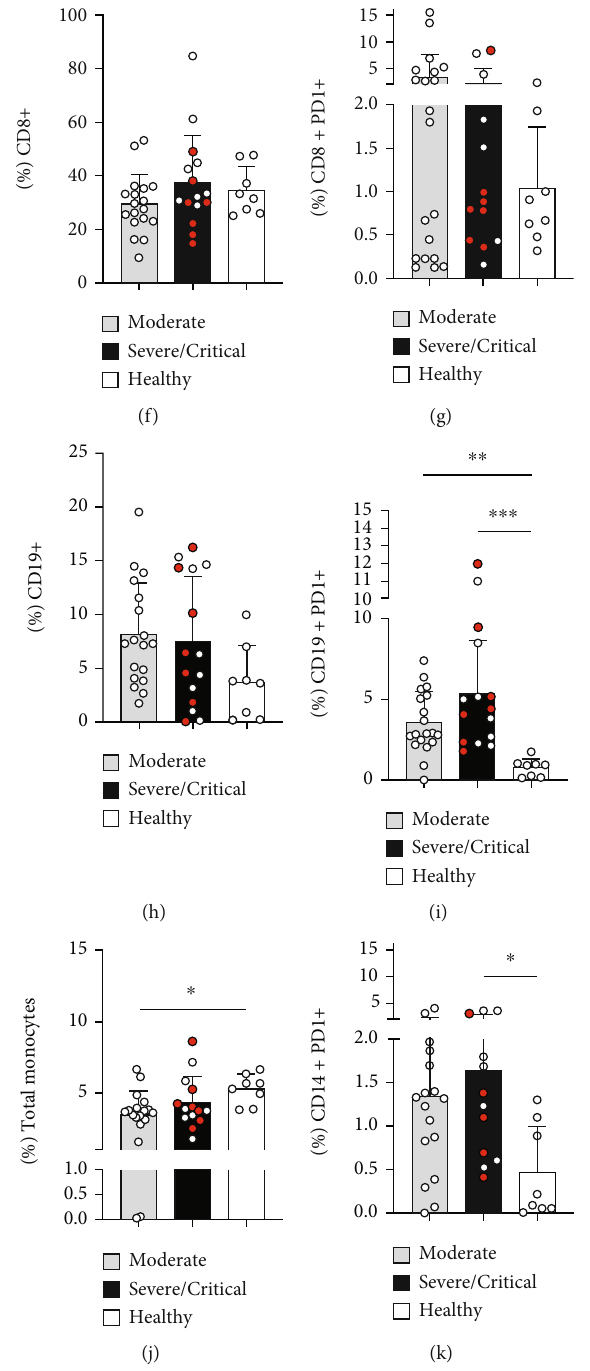
Figure 1: Upregulation of PD-1 in lymphocytes and monocytes of patients with COVID-19. Strategy of the analyses for TCD4+, TCD8+, CD19+, and monocytes expressing PD-1 (a); absolute values of total lymphocytes in patients with moderate ( n = 19 ), severe (open symbol, n = 16 ), and critical (red symbol, n = 6 ) disease and healthy control ( n = 13 ) (b). Frequency of total lymphocytes (c), CD4+ CD3+ T-cells (d), CD4+ PD-1+ T-cells (e), CD8+ CD3+ T-cells (f), CD8+ PD1+ T-cells (g), CD19+ cells (h), CD19+ PD-1+ cells (i), total monocyte frequency (j), and CD14+ PD-1+ cells (k) assessed by fl ow cytometry in peripheral blood samples of control subjects ( n = 8 ) and patients in moderate ( n = 18 ), severe (open symbol, n = 7 ), and critical (red symbol, n = 7 ) clinical status. ∗ P ≤ 0 : 05 , ∗∗ P < 0 : 01 , and ∗∗∗ P < 0 : 001